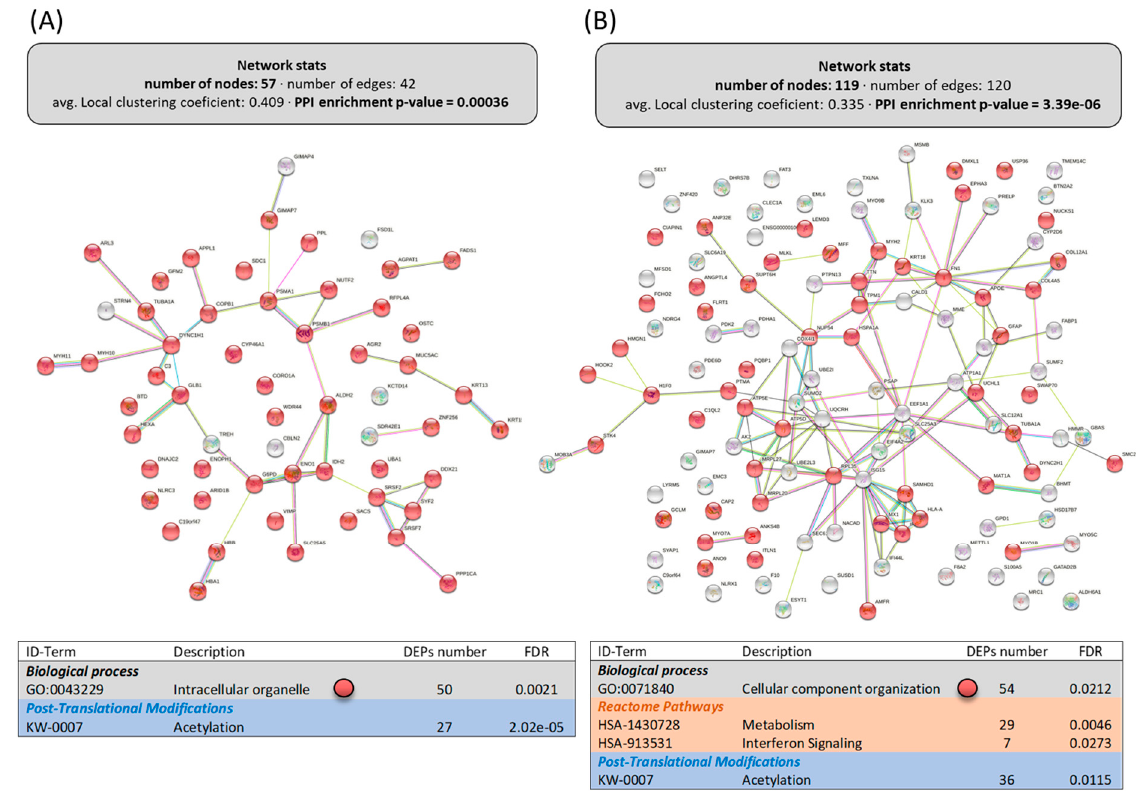
Figure 3. Functional enrichments in the interactomes of upregulated ( A ) and downregulated ( B ) DEPs in the intestine of LPL-fed salmon. Each node represents one differentially expressed protein (DEP) obtained from mucus shotgun proteomics. Details on the functional network statistics (network stats) are indicated ( top ). The selected relevant biological processes ( bottom ) are presented with the corresponding colors in each node. The main Reactome pathways and post-translational modifications (PTMs), clustered significantly by the false discovery rate (FDR) value, are also summarized ( bottom table ).